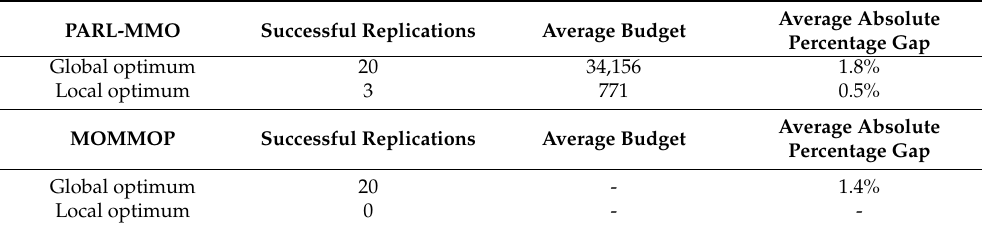
MOMMOP Successful